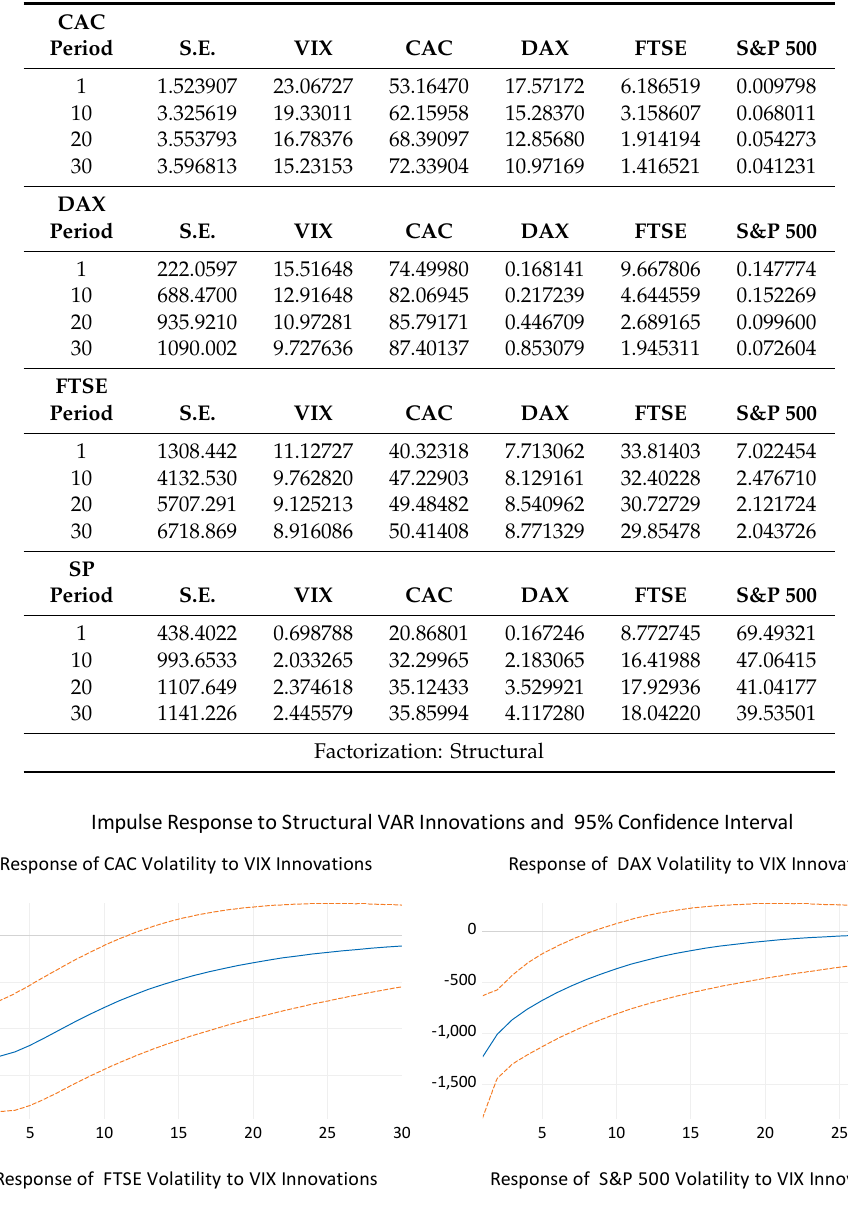
Table 2. Percentage of equity index volatility forecast error variations explained by VIX and Equity Indices, 6 / 24 / 2013–8 / 12 / 2015.